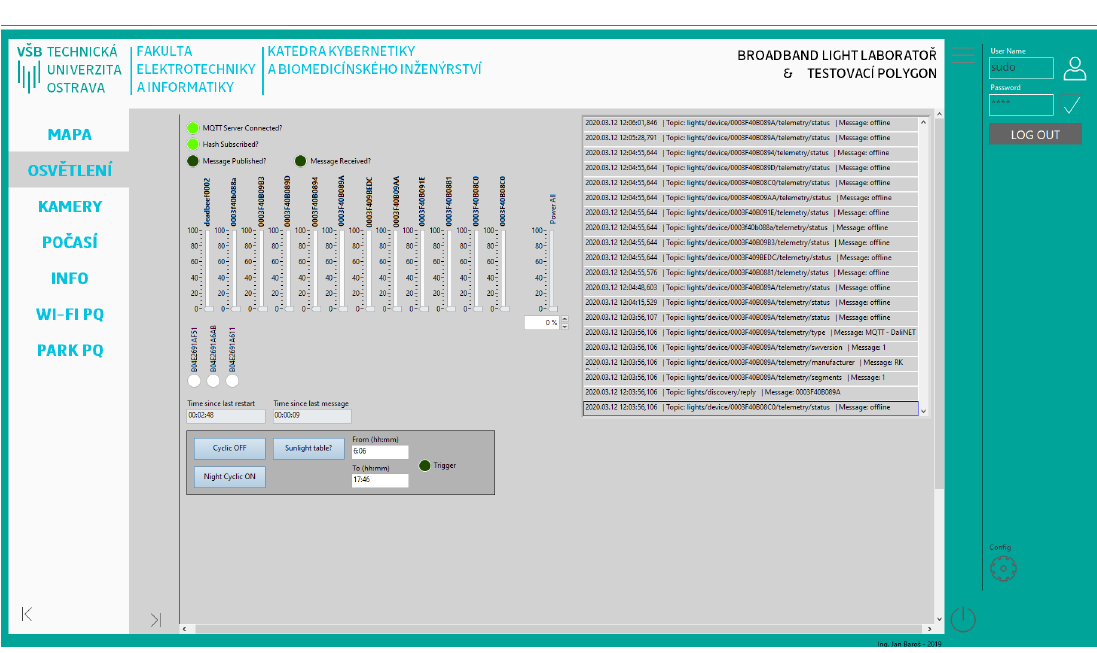
Figure 10. Front panel of control application of testing